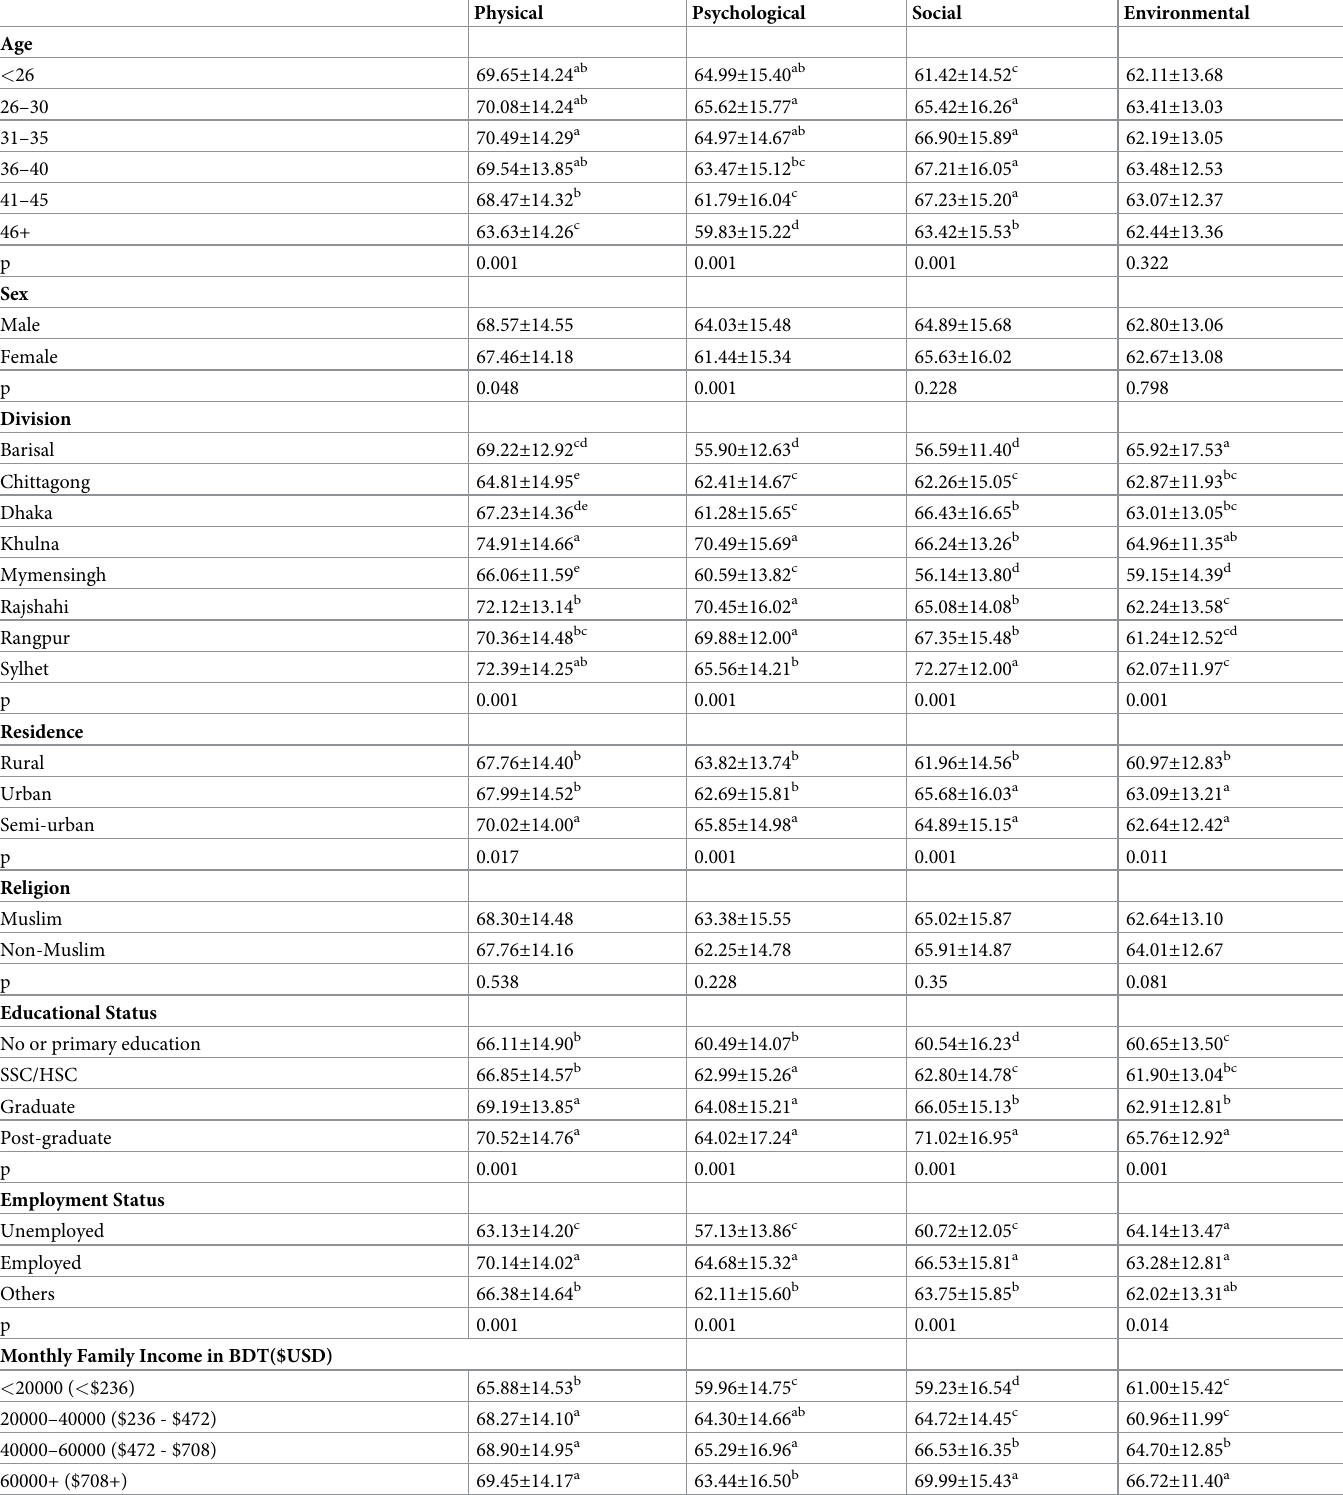
Table 4. Comparison of individual domain score by socio-demographic